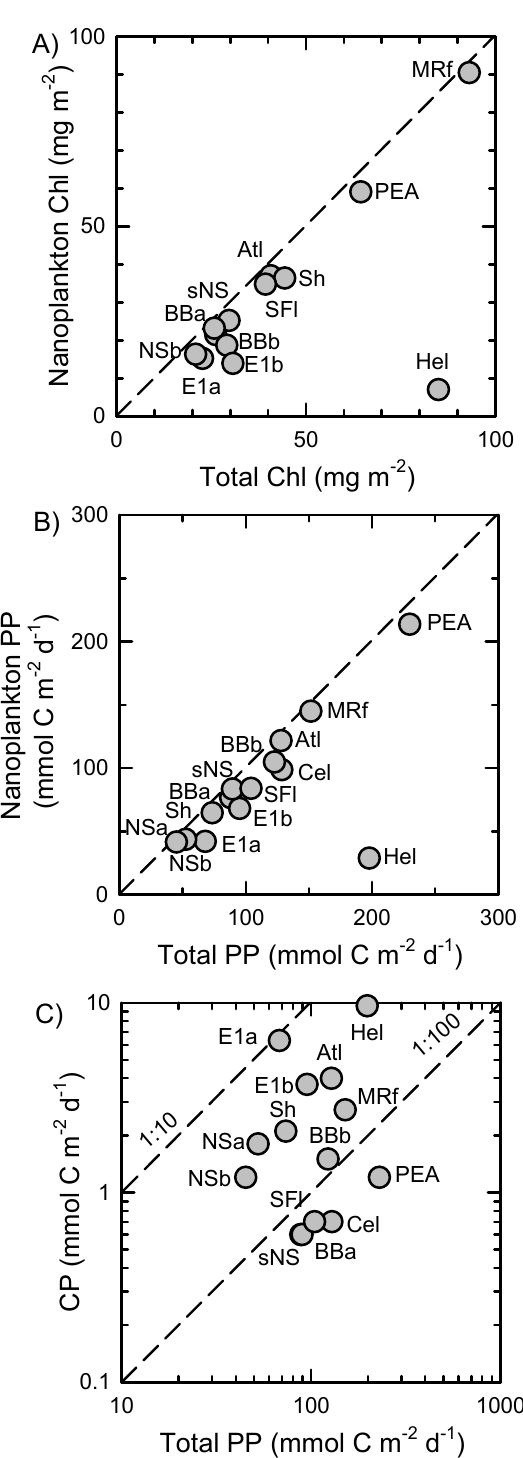
Figure 4. Scatter plots of integrated (A) total Chl and nanoplankton ( < 10µm) Chl (mgm − 2 ), (B) total PP and nanoplankton ( < 10µm) PP (mmolCm − 2 d − 1 ), and (C) calcite production (CP) and total PP (mmolCm − 2 d − 1 ). Dashed lines in (A) and (B) indicate the 1 : 1 line, while dashed lines in (C) indicate ratios of 1 : 10 and 1 :